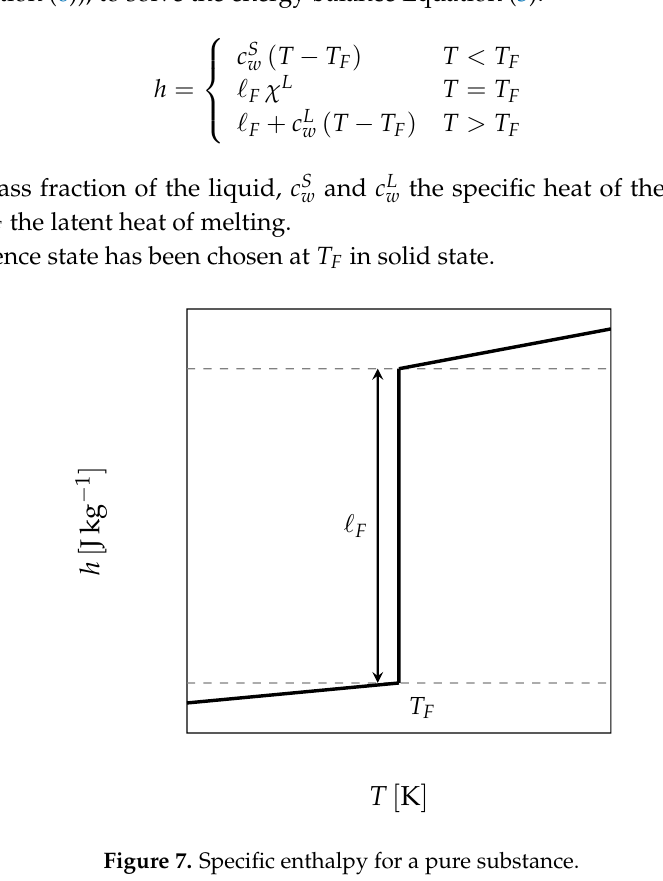
Figure 7: Example of a thermogram of the melting of 11.35 mg of pure ice at 2 K/min.